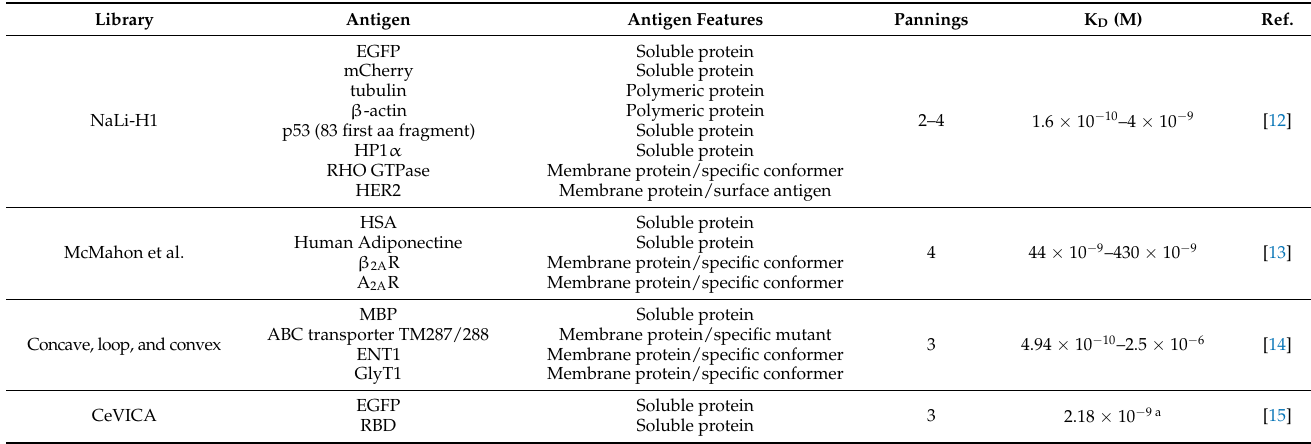
Table 2. Antigens employed to validate the functionality of synthetic